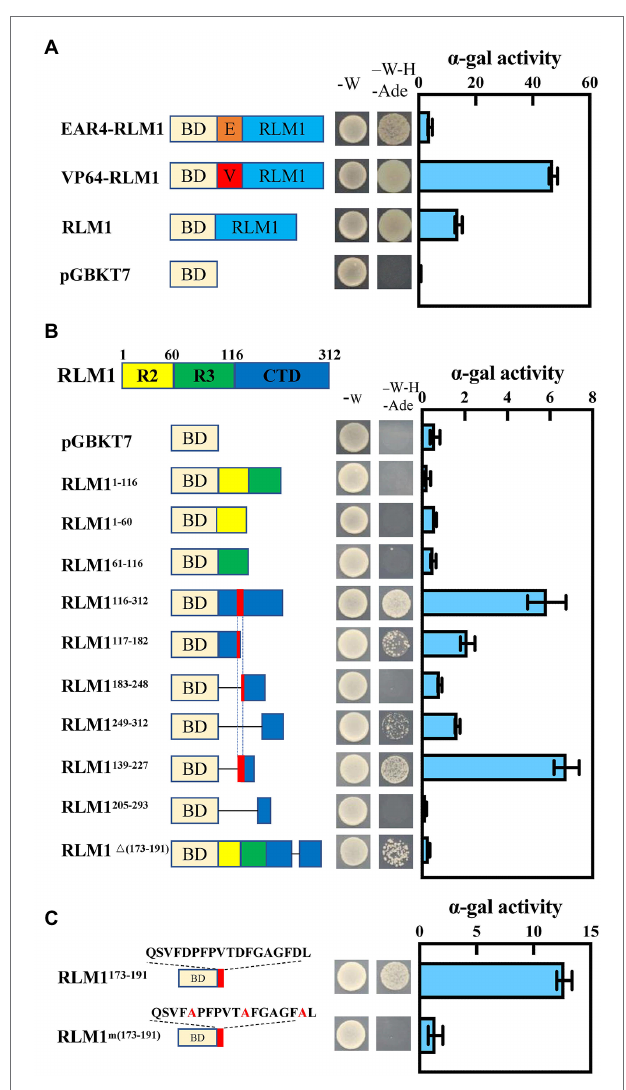
FIGURE 1 | RLM1 acts as a transcriptional activator. (A) Transactivation analysis of RLM1, VP64-RLM1, and EAR4-RLM1 via a yeast assay. VP64 and EAR4 are an exogenous activation domain and an exogenous repression module, respectively. pGBKT7 alone was used as a negative control. Plate auxotroph and α -galactosidase assay showing the transcriptional activation of each protein. The bars represent the means ± SDs of three independent experiments. α -gal, α -galactosidase; -W, SD/-Trp; -W-H-Ade, SD/-Trp/-His/-Ade. (B) Mapping of the transactivation motif of RLM1 via a yeast assay. R2, aa 1–60; R3, aa